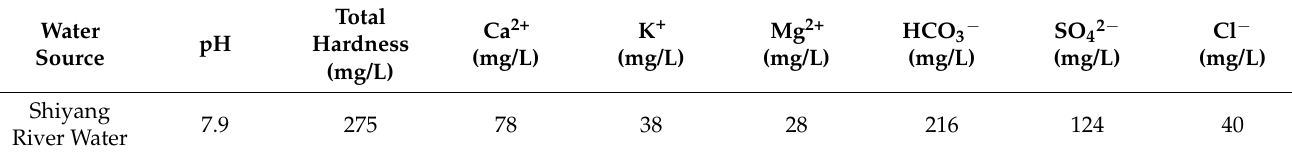
Table 1. Chemical parameters of Shiyang River water.